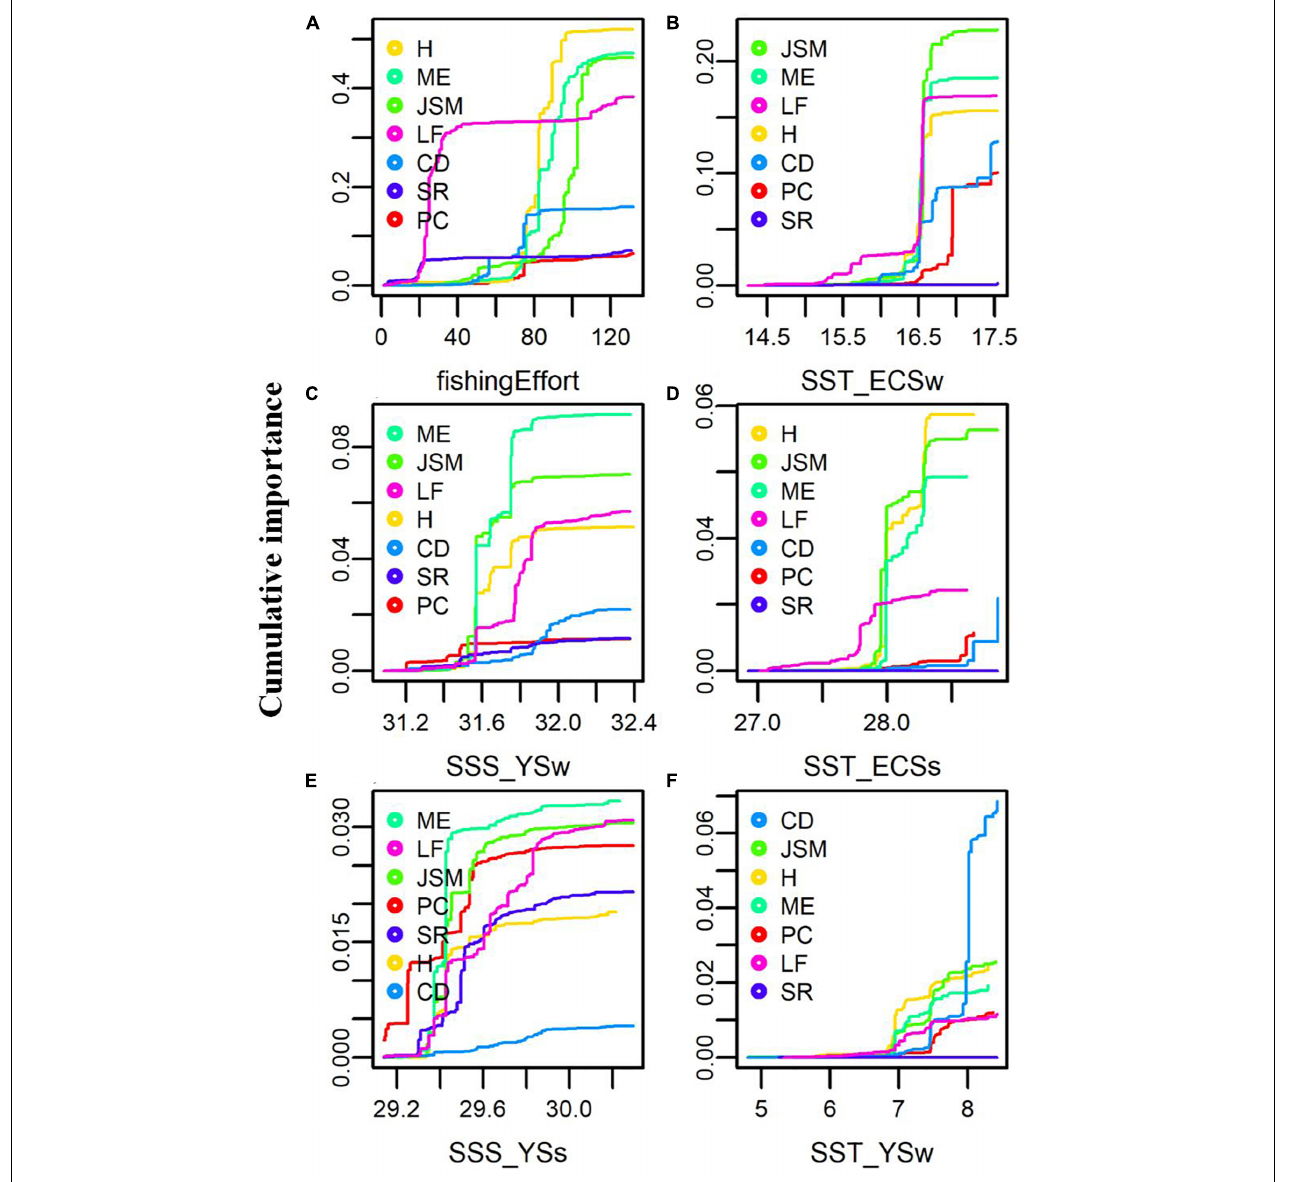
FIGURE 9 | Cumulative importance of piscivorous fish catch in response to the first six important predictor variables including (A) fishing effort, (B) sea surface temperature (SST) in East China Sea winter (ECSw), (C) sea surface salinity (SSS) in Yellow Sea winter (YSw), (D) SST in East China Sea summer (ECSs), (E) SSS in Yellow Sea summer (YSs), and (F) SST in Yellow Sea winter (YSw). PC, H, ME, JSM, CD, SR, and LF represent Pacific cod, hairtail, marine eel, Japanese-Spanish mackerel, common dolphinfish, sharks and ray, and lizardfish,